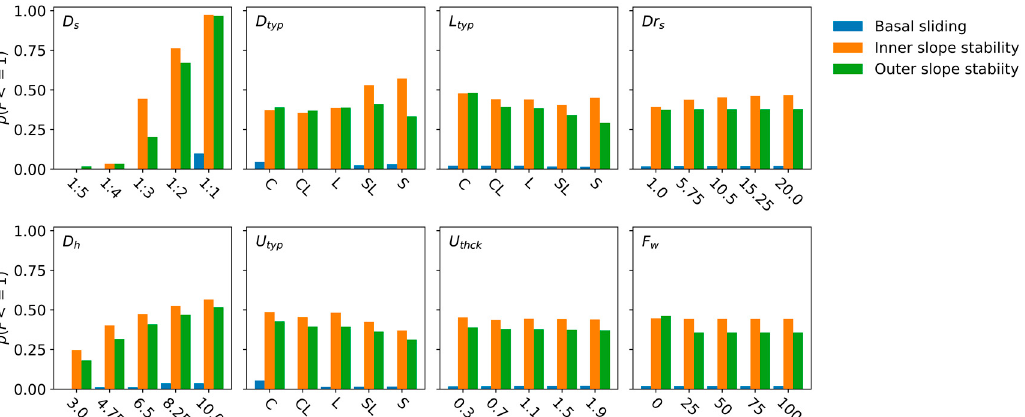
Figure 8. Probability of failure p ( F ≤ 1 ) given that the selected input factor is fixed at the given value on the x-axis, and all other input factors are not fixed. Where p ( F ≤ 1 ) equals 0 all calculated dikes are stable, and with a p ( F ≤ 1 ) of 1, all calculated dikes fail. A large difference in the probability of failure between neighboring bars indicates a strong local importance of that factor.